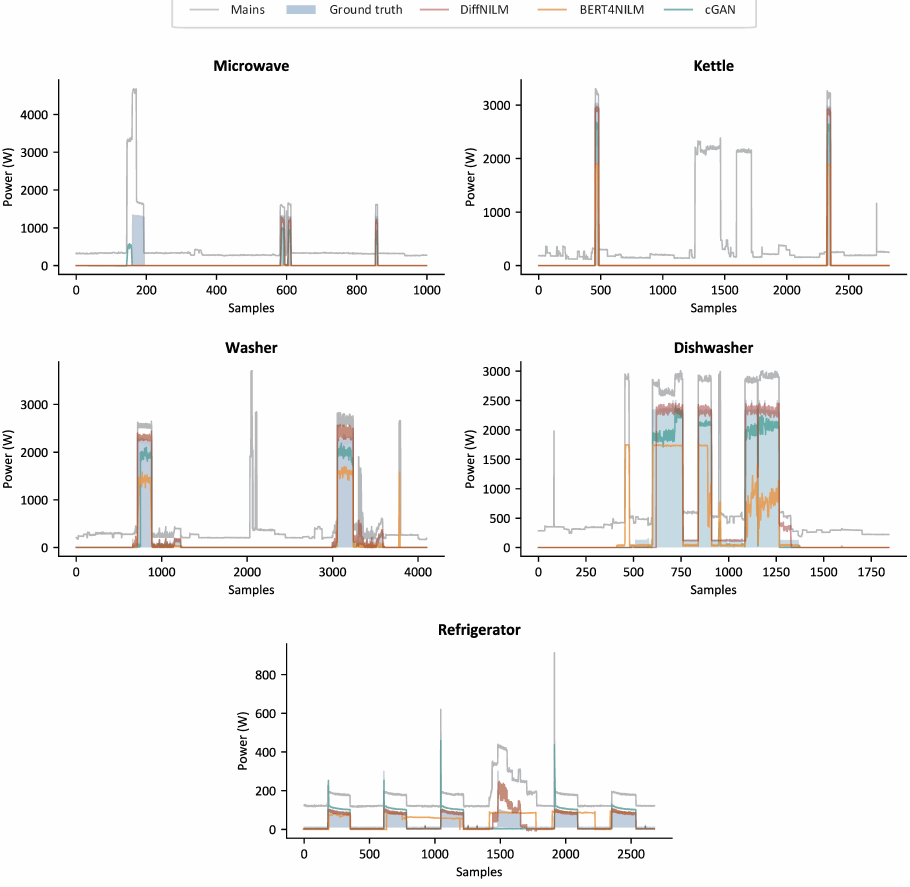
Figure 8. Sample outputs of microwave, kettle, Washer, dishwasher and refrigerator on